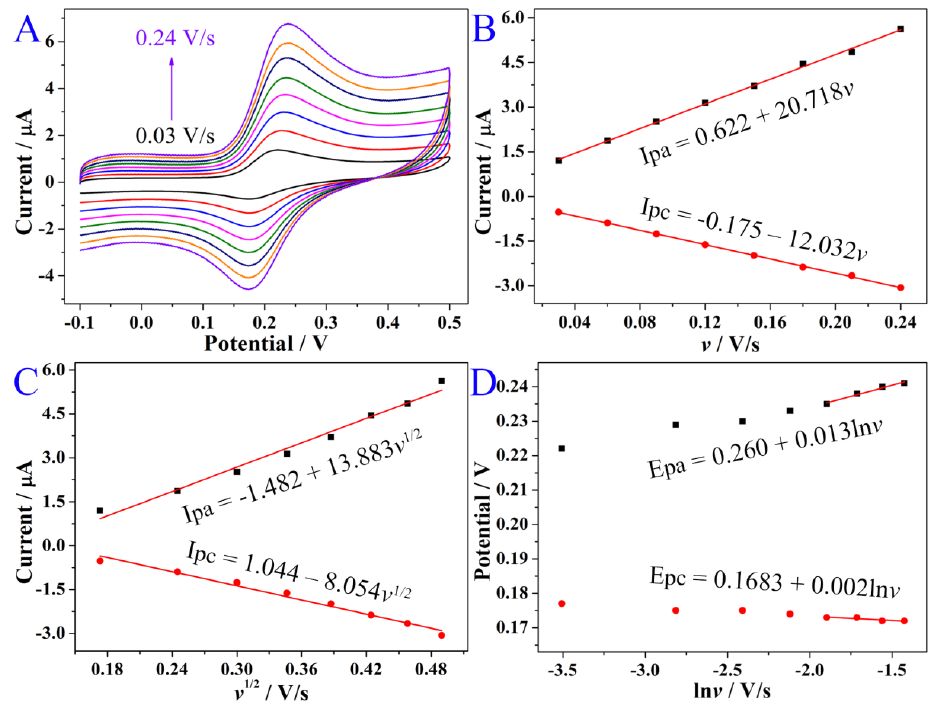
Figure 5. The CV of Cs@MoS 2 -Pd NPs/GCE in 10 µ M QR ( A ); the relationship between peak current and v ( B ) and v 1/2 ( C ); rhe relationship between peak potential and ln v ( D ).